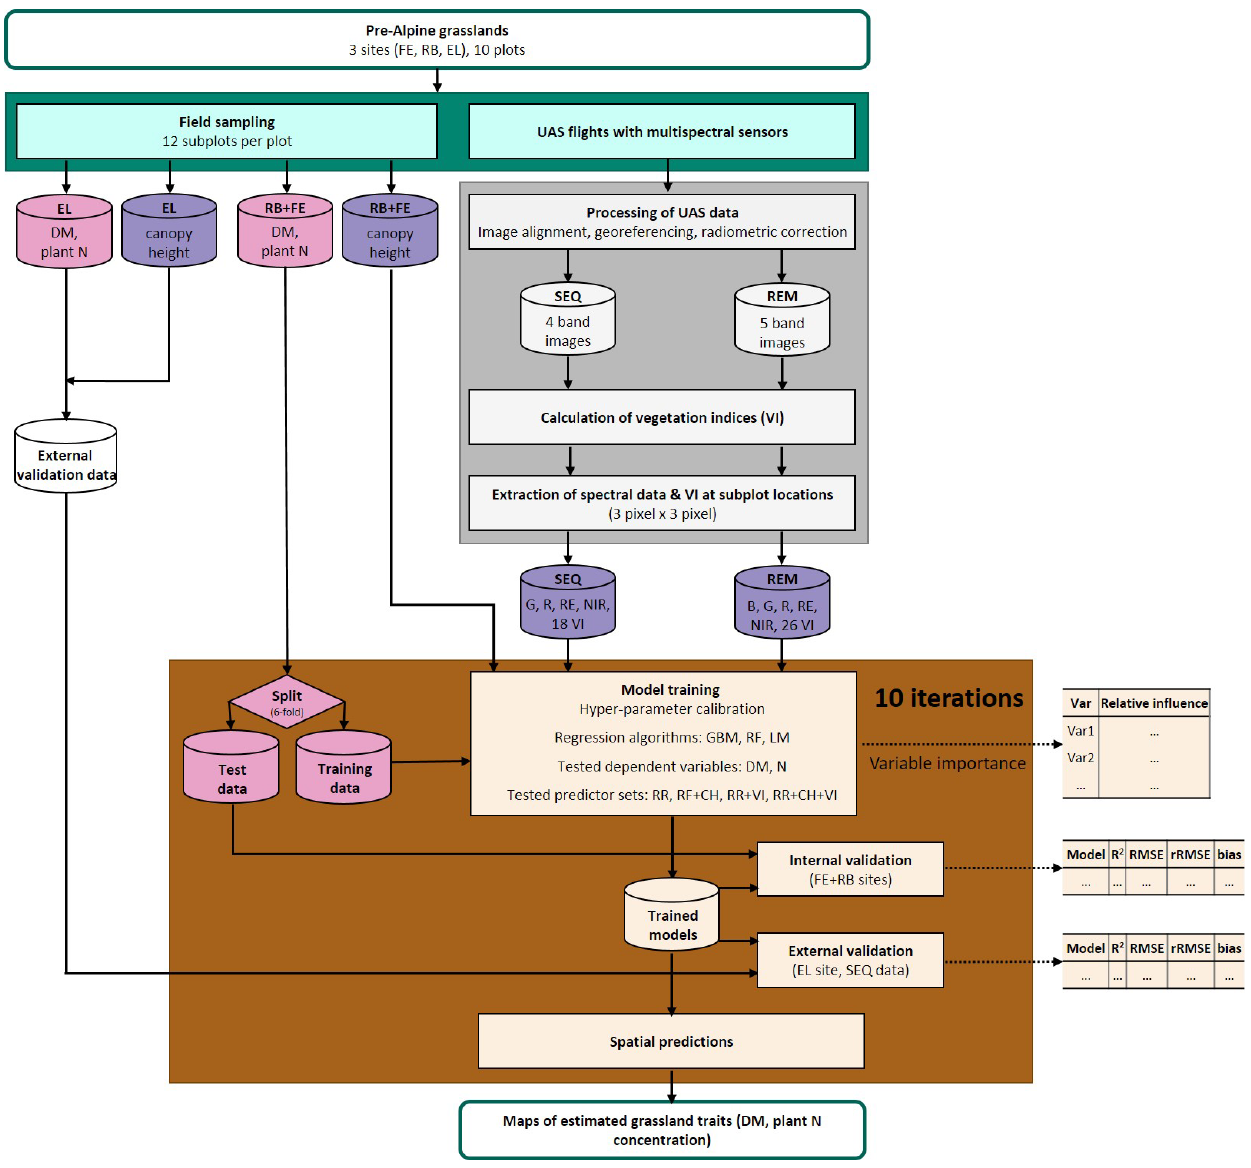
Figure 2. Workflow of data acquisition in the field (blue-green); spectral data processing (grey); and model building, validation, and appli- cation (brown). Response variables of the model are shown in pink, and predictor variables are in violet. Explanation of abbreviations: sam- pling sites (FE: Fendt, RB: Rottenbuch, EL: Eschenlohe), predictor variables (B: blue band, G: green band, R: red band, RE: red-edge band, NIR: near-infrared band, VIs: vegetation indices, CH: canopy height), dependent variables (DM: dry matter, N: nitrogen concentration), and regression algorithms (GBM: gradient-boosting machine, RF: random forest, LM: linear